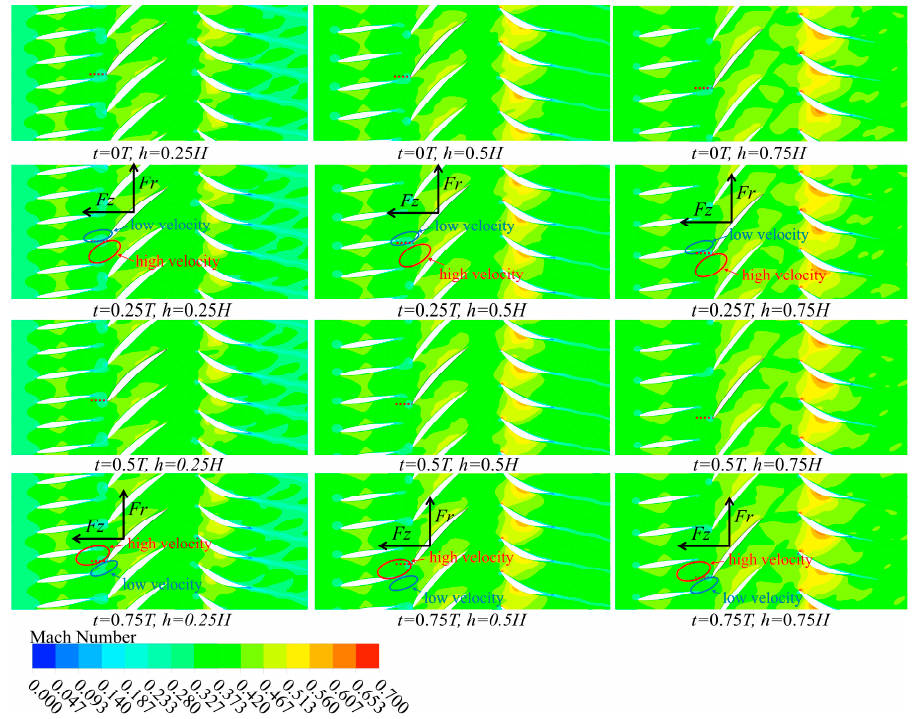
Figure 20. Mach number distribution of the a = 5 mm model under near-blockage